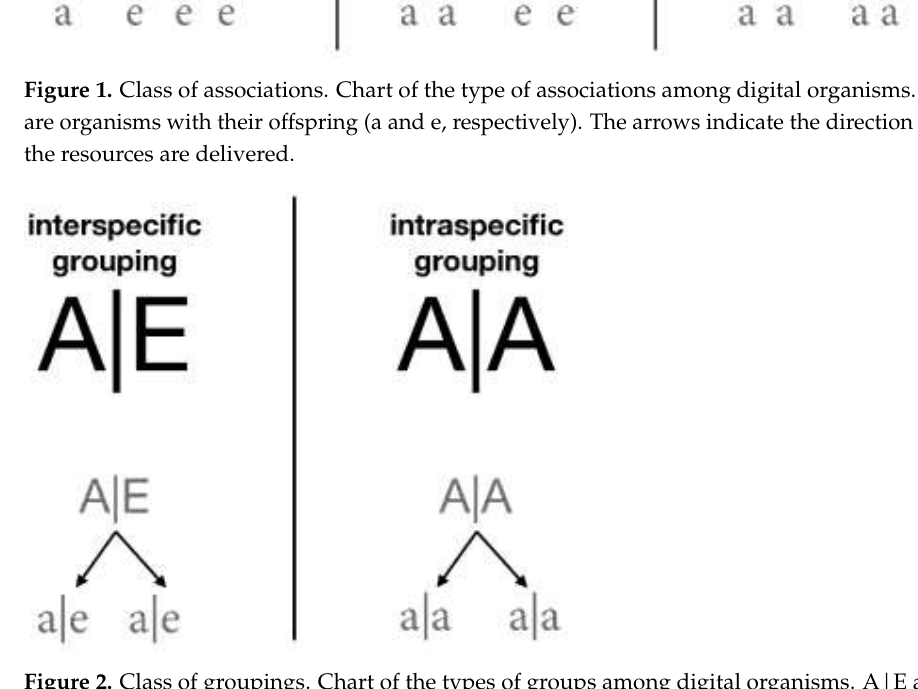
Figure 2. Class of groupings. Chart of the types of groups among digital organisms. A|E and A|A are group of organisms with their offspring a|e and a|a, respectively). The arrows indicate the direction in which the resources are delivered